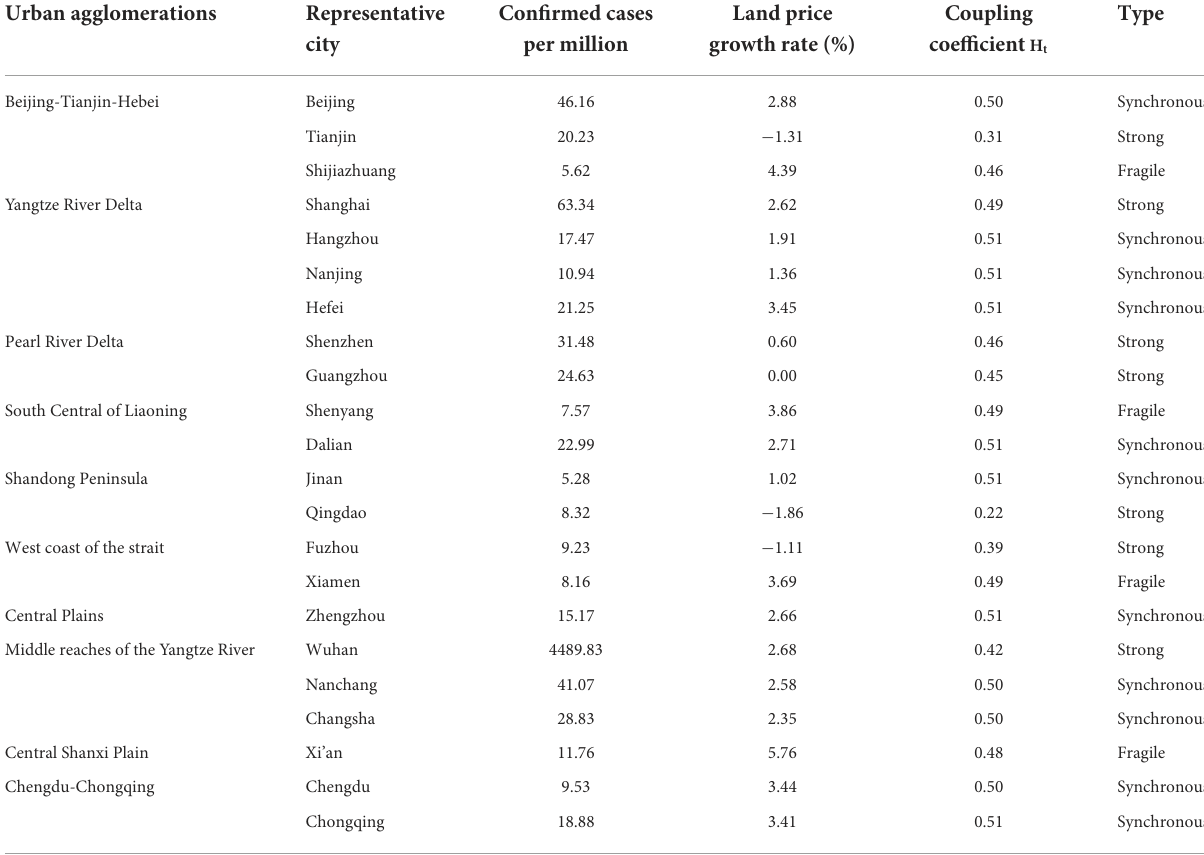
TABLE 2 Results of coupling